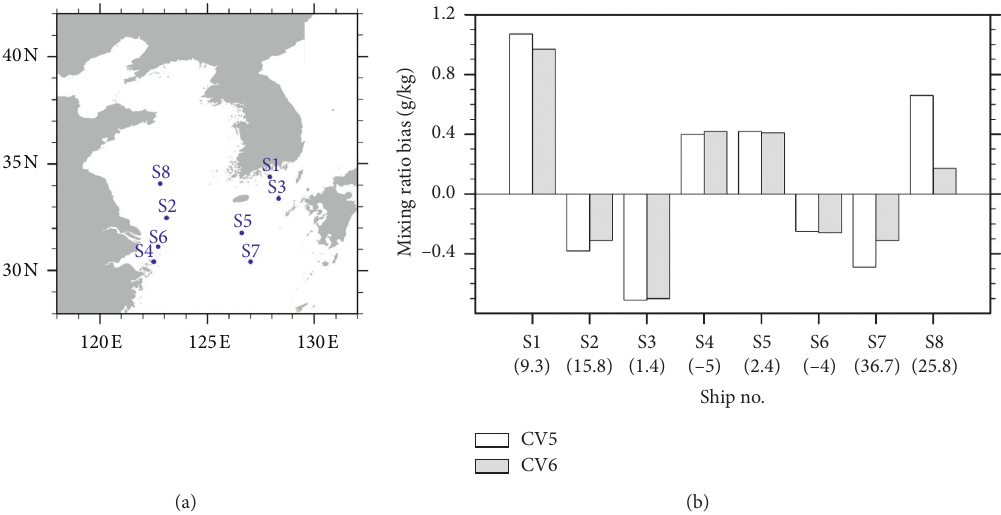
Figure 14: Locations of ship measurements (a) and biases of forecasted mixing ratio compared with observation (b) for Case-B. The improvements (%) of Exp-B_CV6 compared to Exp-B_CV5 are presented below the S# (identified mark of ship sites) along horizontal